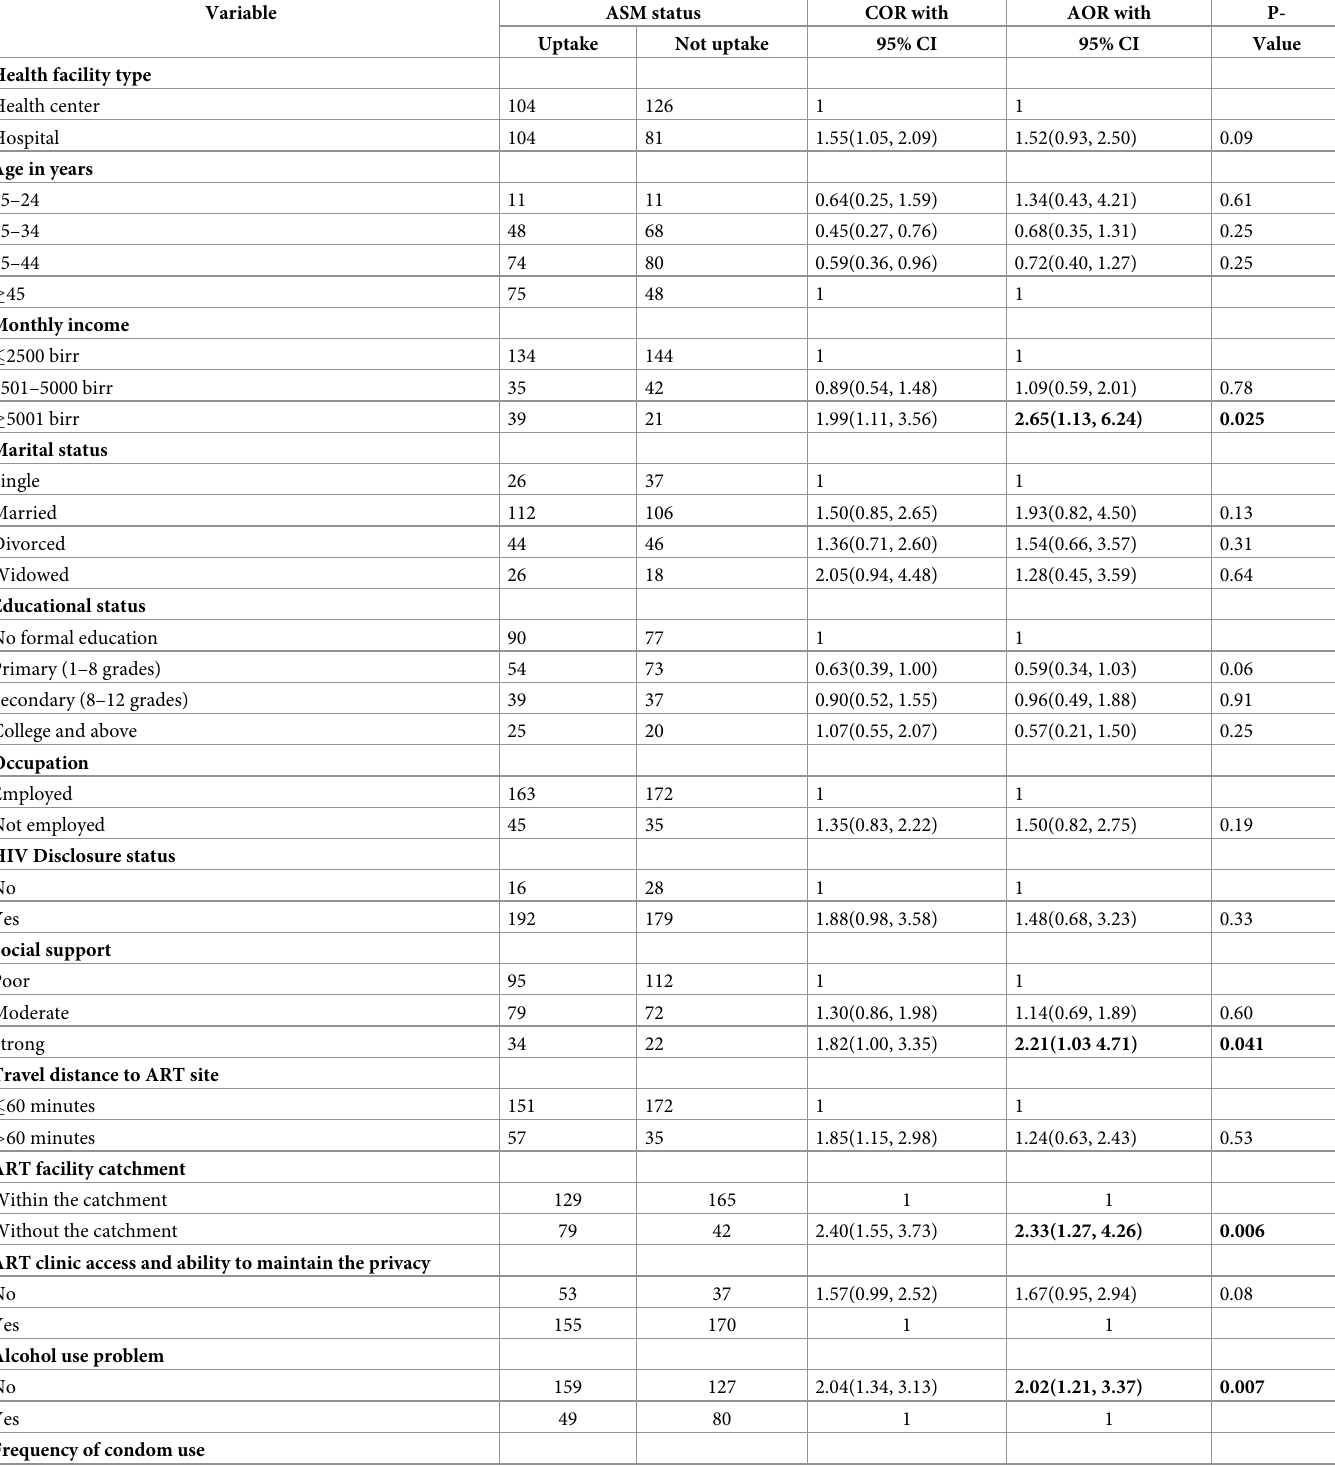
Table 4. Bi-variable and multi-variable analysis uptake of ASM among stable clients on antiretroviral treatment, East Gojjam Zone, Northwest Ethiopia, 2020 (n = 415).